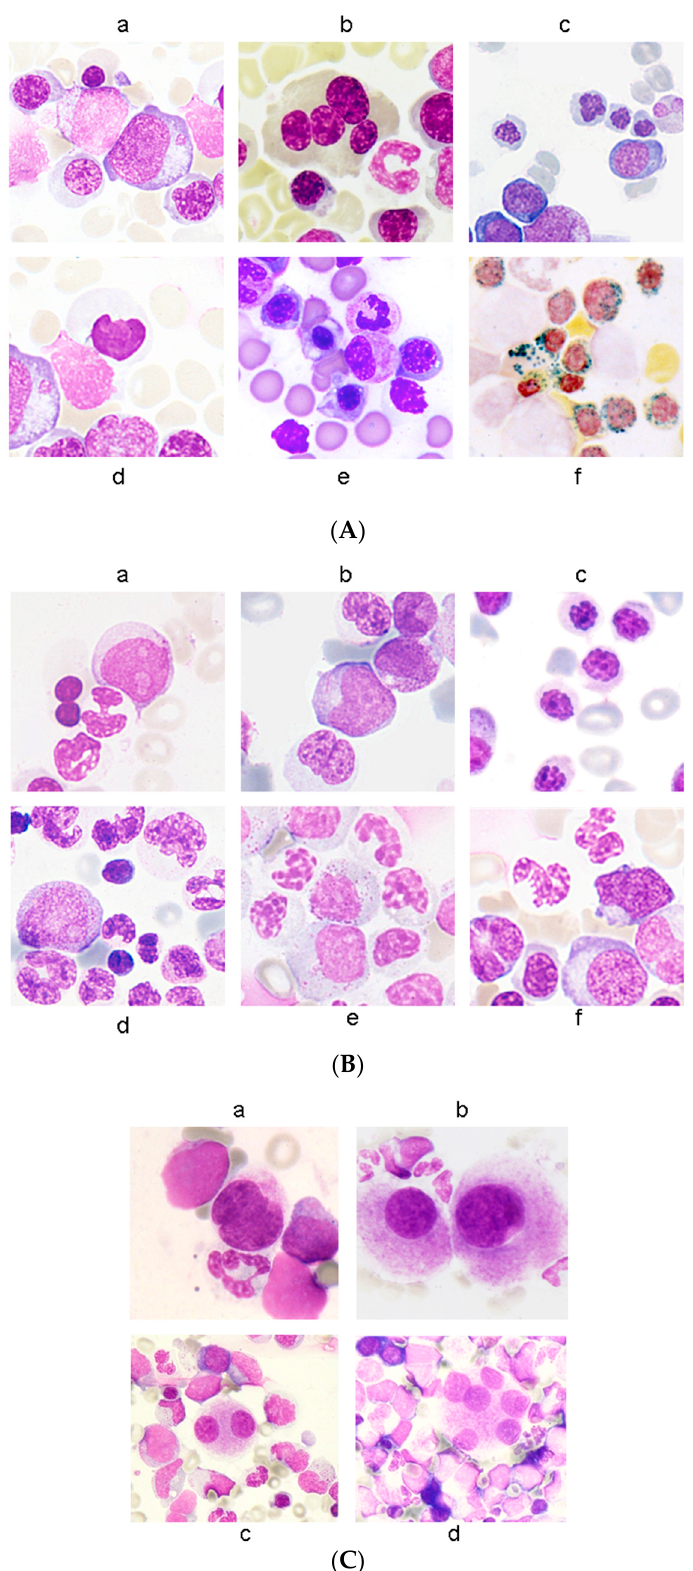
Figure 1. ( A ) Erythroid dysplasia (100×). ( a ) megaloblastosis; ( b ) multinuclearity; ( c ) nuclear lobulation; ( d ) pyknosis; ( e ) defective hemoglobinization and cytoplasmic fraying; ( f ) ring sideroblasts. Adapted from Della Porta et al. [9]; ( B ) Granulocytic dysplasia (100×). ( a ) myeloblast; ( b ) Auer rod; ( c ) hypolobulation; ( d , e ) abnormal nuclear shape; ( f ) hypogranulation. Adapted from